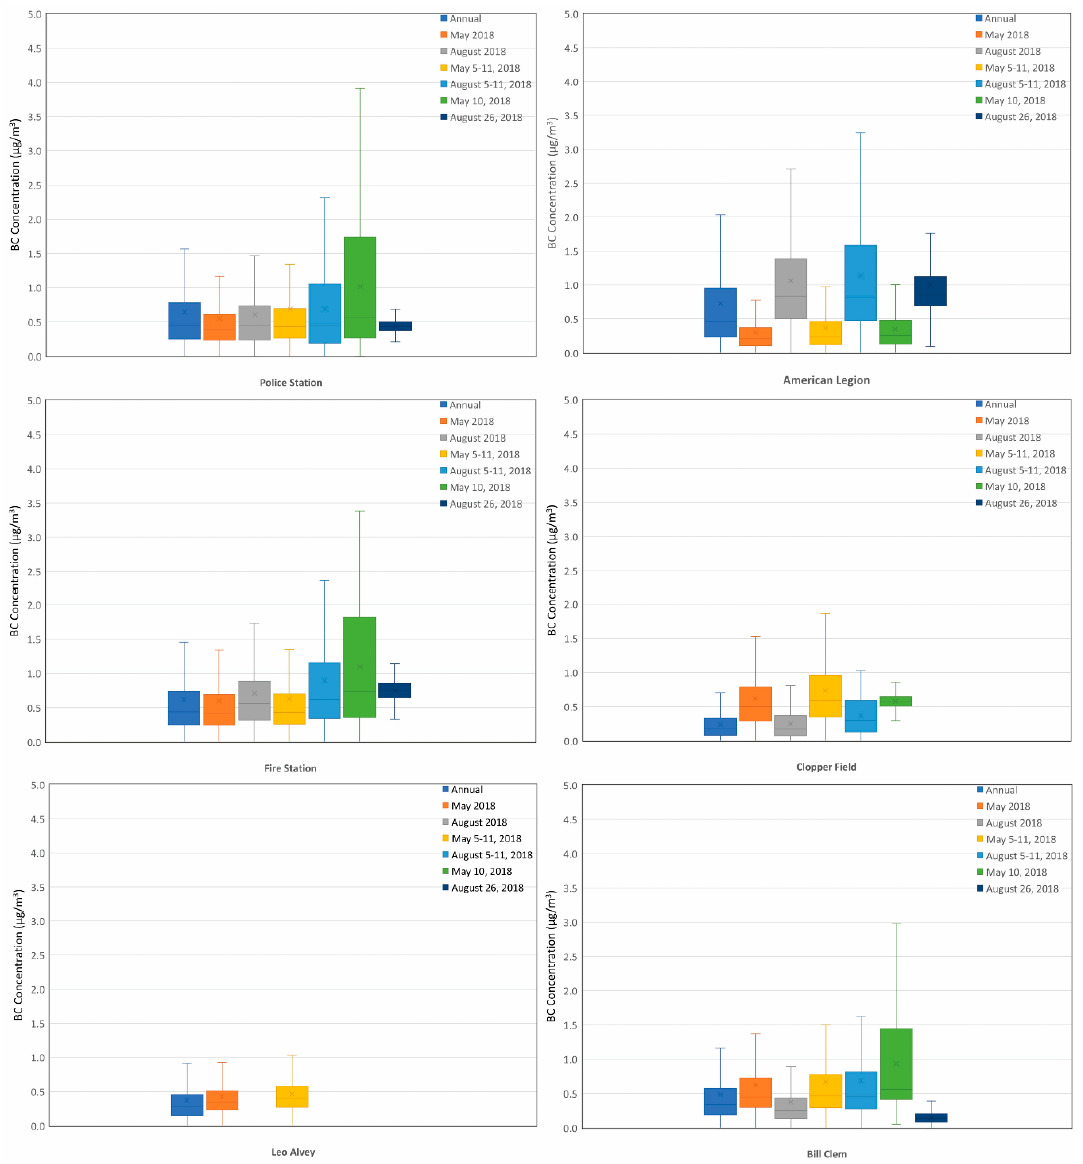
Figure 5. Box plots for the P-POD BCIR measurements for different time periods: Annual (24 October